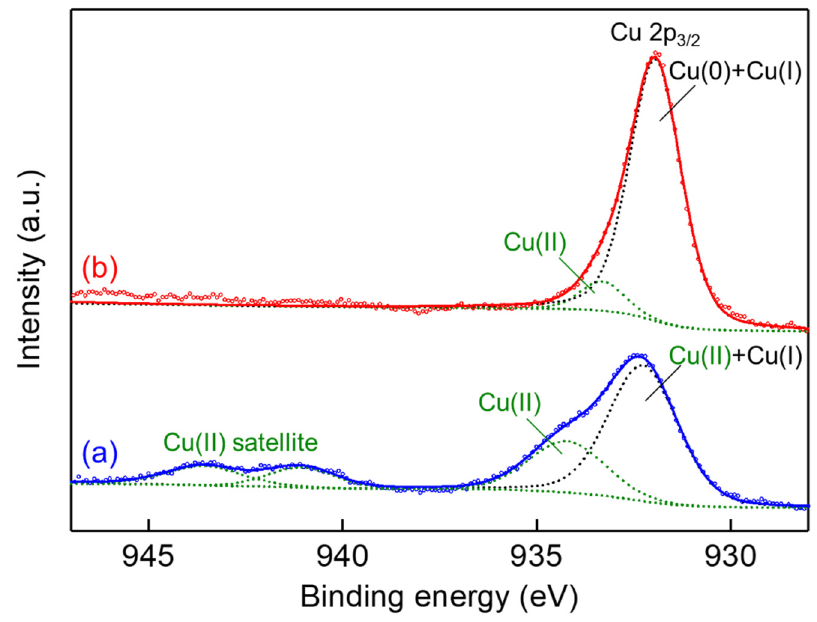
Figure 4. Deconvoluted Cu 2p 3/2 XPS spectra of Cu-TiO 2 ( a ) and Cu-TiO 2 -H ( b ). The observed spectra, fitting curves, calculated patterns, and deconvoluted curves are denoted by circle, solid line, and dashed line, respectively.